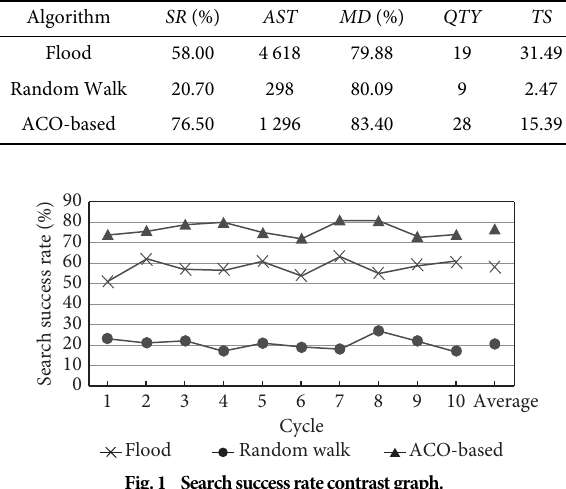
Fig. 1 Search success rate contrast graph.